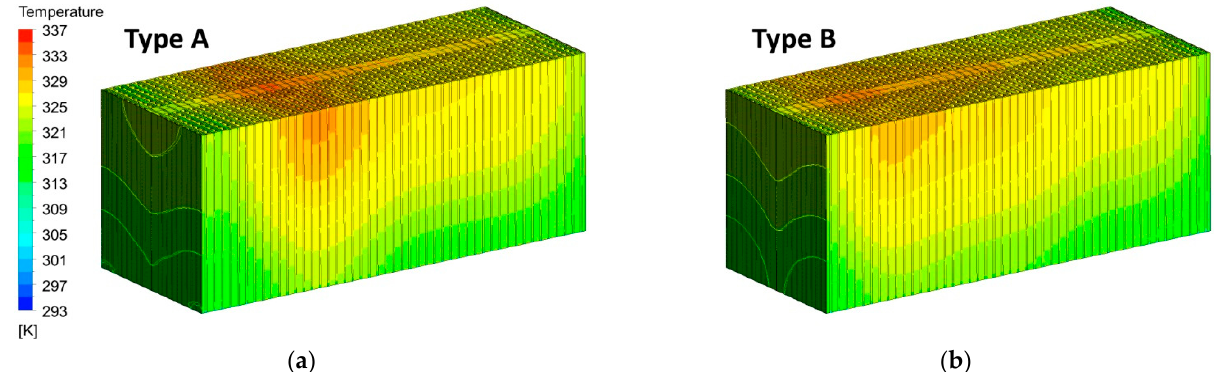
Figure 15. Temperature distribution on the proton-exchange membrane (PEM) stack across ( a ) Type A and ( b ) Type B.